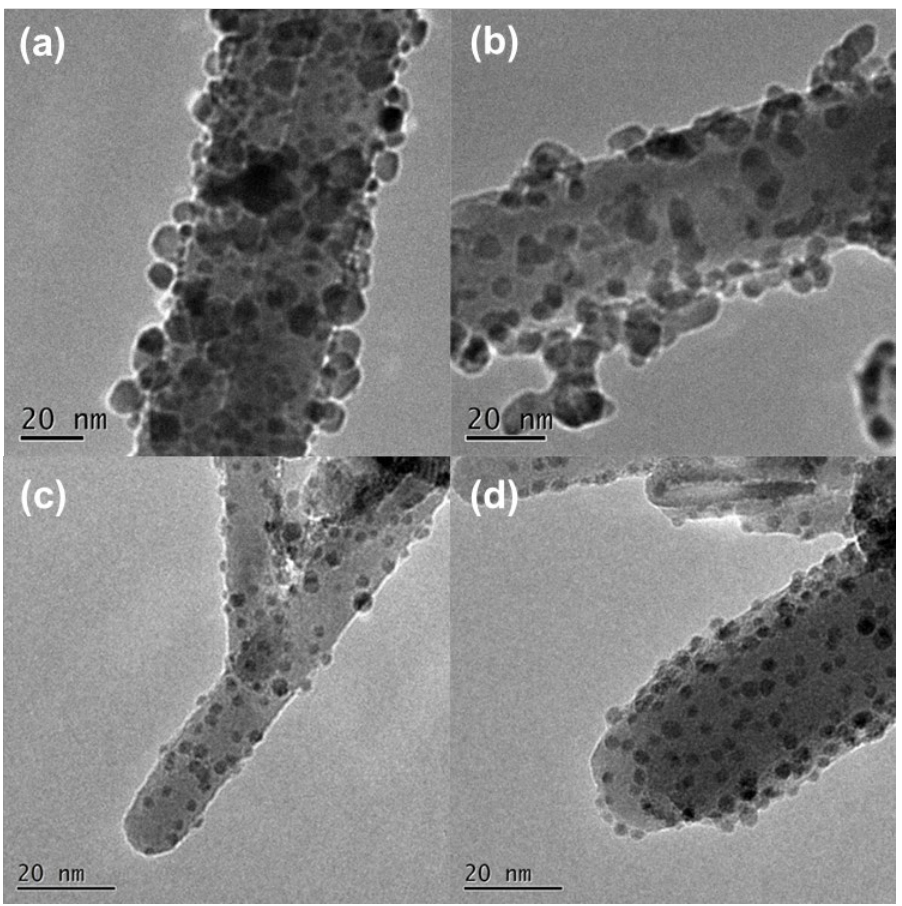
Figure 2. TEM images of ( a ) ZnO/Pd-0, ( b ) ZnO/Pd-1, ( c ) ZnO/Pd-2 and ( d ) ZnO/Pd-3. The sensing properties of ZnO and four ZnO/Pd samples to 500 ppm CH 4 at different temperatures were tested, and the response results are summarized in Figure 3. Compared with ZnO, four ZnO/Pd samples all showed improved CH 4 sensing performance with decreased optimal temperatures (280 ◦ C to 230 ◦ C) and increased responses, indicating the catalytic promotion by Pd. The CH 4 response increased as the size of Pd NPs decreased, and ZnO/Pd-2 and ZnO/Pd-3 show the highest CH 4 response at about 27%. Thus, it can be concluded that CH 4 responses have a negative correlation to the size of Pd NPs; i.e., it is positively correlated with the dispersity of Pd. The smaller the particle size of Pd NPs, the better the dispersity of Pd, and the higher the response value of ZnO/Pd relative to CH 4 . Pd contents in four ZnO/Pd materials were analyzed using ICP. It was found that Pd contents were 3.26%, 2.49%, 1.35% and 1.41 wt% for ZnO/Pd-0, 1, 2, and 3, respectively. Combined with TEM observations, both the size and the amount of Pd cannot be further reduced by adding more